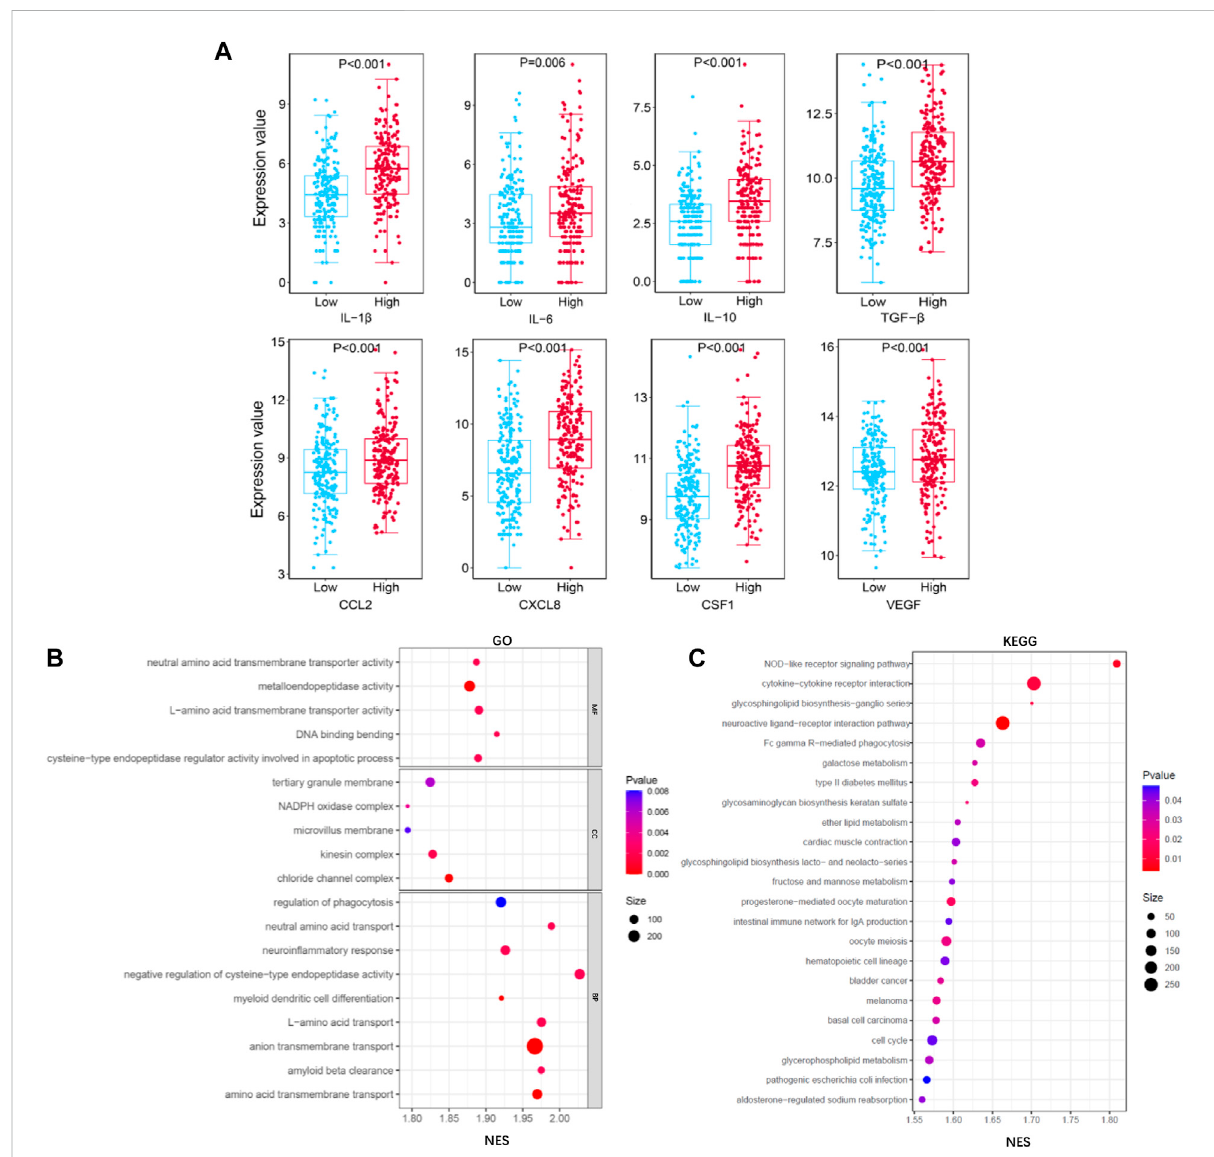
FIGURE 9 Functional analysis for TIMGs. (A) Comparison of the expression value of cytokines (IL-1 β , IL-6, IL-10, TGF- β , CCL2, CXCL8, CSF-1, and VEGF) withdifferentgroupsofTIMSigintheTCGAcohort. (B) GOfunctionanalysisofTIMSigintheTCGAcohort. (C) KEGGpathwayanalysisofTIMSiginthe TCGA